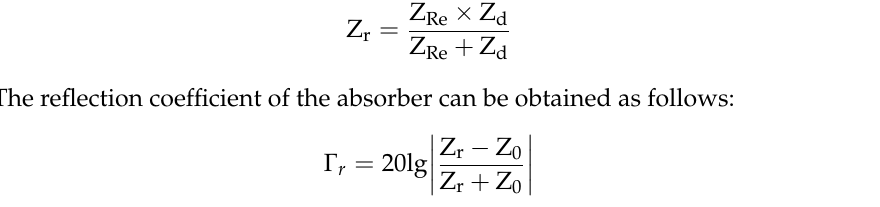
Figure 11. ( a ) Photograph of the fabricated sample; ( b ) photograph of the experimental environ- ment. The experimental results follow the same trend as the simulation shown in Figure 12. Figure 12a shows the measured absorptance for forward and backward incidence under both TE and TM polarizations, and we can see that the absorptance is greater than 0.9 in 1.43 – 2.51 GHz with a fractional bandwidth of 55%. Figure 12b,c shows that the bi-direc- tional MPA is polarization-insensitive for both TE and TM polarizations. The measured results basically coincide with the simulated results. These experimental results prove that our previous simulations are basically correct.